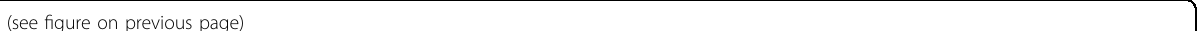
Fig. 5 Prophylactic and therapeutic effect of G9 against SARS-CoV-2 infection of lung, brain, and associated disease in hACE2-transgenic mice. a Experimental scheme of the animal model. b Bodyweight changes in SARS-CoV-2-infected HFH4-hACE2-transgenic mice in the prevention group (P), treatment group (T), and PBS group of GW01 and G9. The percentage of weight change was calculated on day 5 for all animals. The symbol “ + ” signi fi es that the mice died. c , d Viral load as assessed by S gene RNA RT – PCR from lung tissue of the GW01 and G9 groups ( c ) or brain tissue from the G9 groups ( d ) on day 5 post infection. e Pathological changes in HFH4-hACE2-transgenic mouse lung on day 5 after SARS-CoV-2 infection. Mouse lung tissue was stained with H&E to observe pathological changes. Scale bars, 200 μ m. f Viral antigen was detected by anti-SARS- CoV-2 N protein polyclonal antibody (red) in lung bronchi and alveoli collected 5 DPI. Images were collected using a Pannoramic MIDI system (3DHISTECH, Budapest). Scale bars, 100 μ